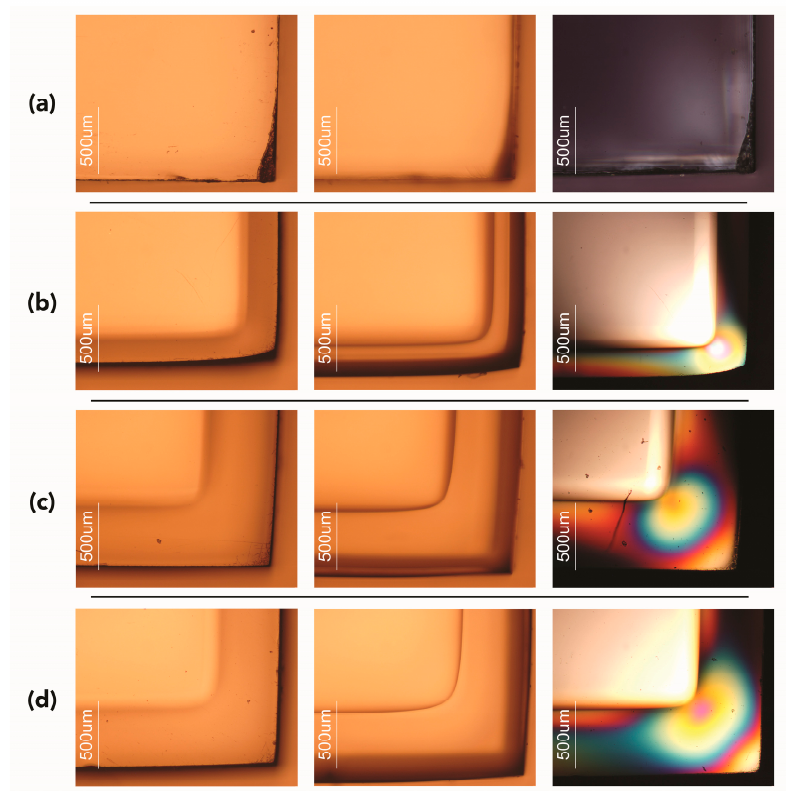
Figure 5. Representative microphotographs in brightfield (left and middle columns) and cross- polarized light (right column) showing the optical boundary and the isochromatic fringes for ( a ) con- trol untreated sample, ( b ) sample exposed to vapor CO 2 at 25 °C and 6 MPa, ( c ) sample exposed to liquid CO 2 at 25 °C and 10 MPa, ( d ) sample exposed to supercritical CO 2 at 35 °C and 10 MPa. Note: images in the left column were focused on the surface, while images in the middle column were focused inside the sample to better visualize the optical boundary, and hence, the surface appears slightly unfocused. Magnification ×50.